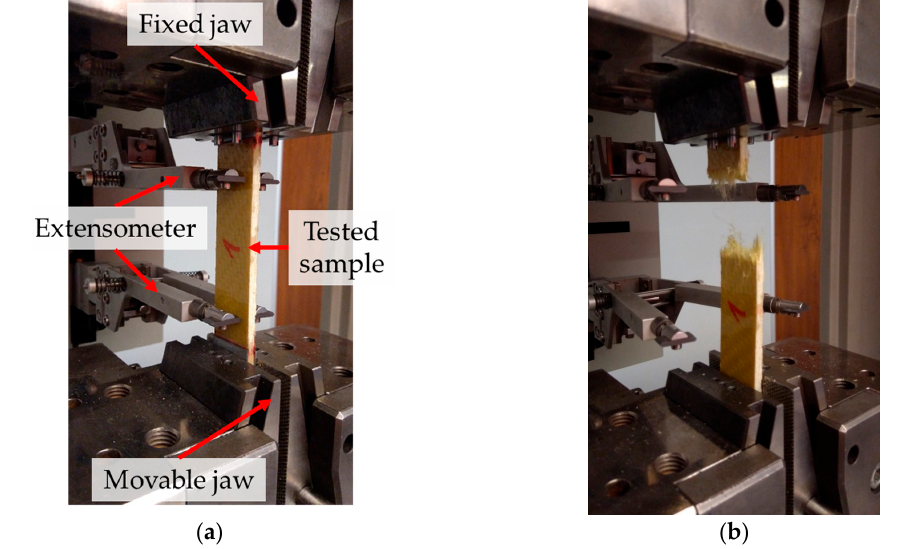
Figure 10. Tensile test of a composite sample reinforced by Twaron 2200 fibers: ( a ) sample (with active extensometer) placed in the jaws, ( b ) sample after rupture.